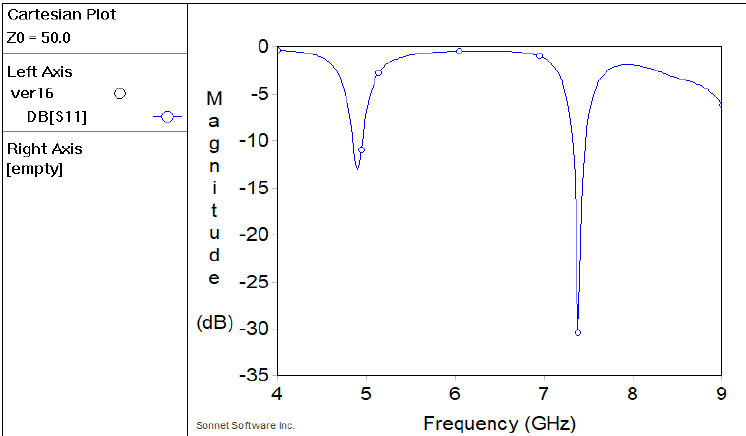
Figure 2. Input match response of dual resonance patch